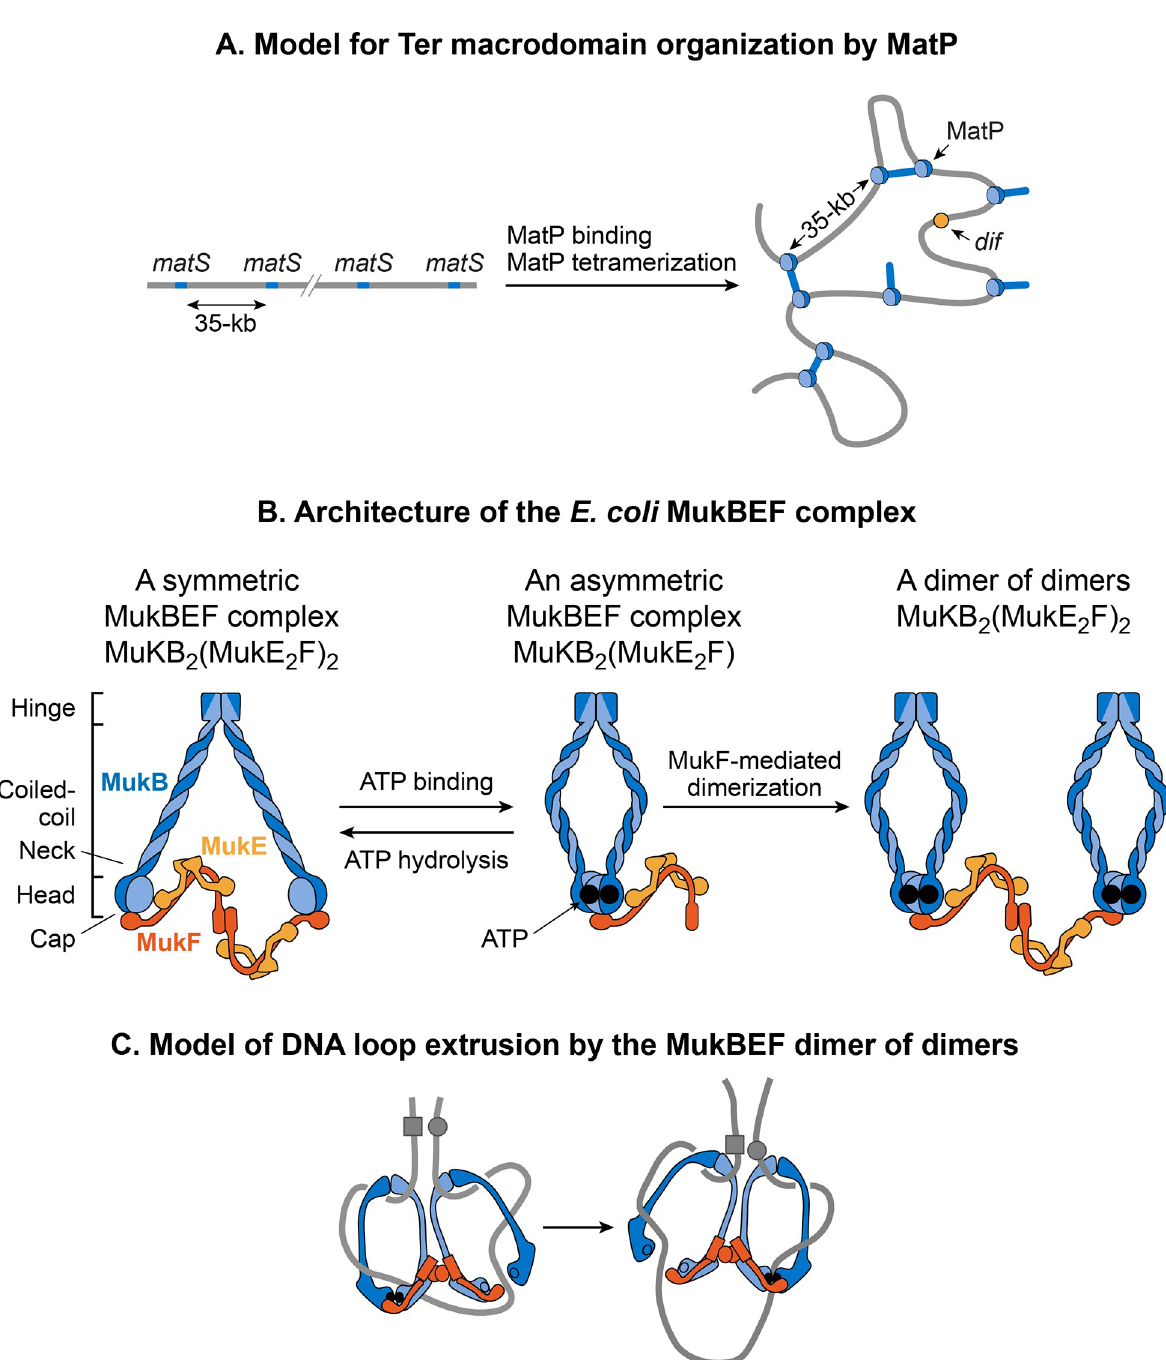
Fig 10. Models for DNA organization by MatP and MukBEF. A. A matS -bridging model for DNA organization in the Ter macrodomain by MatP. MatP recognizes a 13-bp signature DNA sequence called matS that is present exclusively in the Ter macrodomain. There are 23 matS sites separated by one another by an average of 35-kb. MatP binds to a matS site as a dimer, and the tetramerization of the DNA-bound dimers bridges matS sites forming large DNA loops. B. The architecture of the E . coli MukBEF complex. The complex is formed by protein-protein interactions between MukB (blue), MukF (dark orange) and MukE (light orange). MukB, which belongs to the family of structural maintenance of chromosomes (SMCs) proteins, forms a dimer (monomers are shown by dark and light blue colors) consisting of an ATPase head domain and a 100 nm long intramolecular coiled-coil with a hinge region in the middle. Because of the flexibility of the hinge region, MukB adopts a characteristic V- shape of the SMC family. MukF also tends to exist as a dimer because of the strong dimerization affinity between monomers [134, 135]. The C- terminal domain of MukF can interact with the head domain of MukB while its central domain can interact with MukE. Two molecules of MukE and one molecule of MukF associate with each other independent of MukB to form a trimeric complex (MukE 2 F). Since MukF tends to exist in a